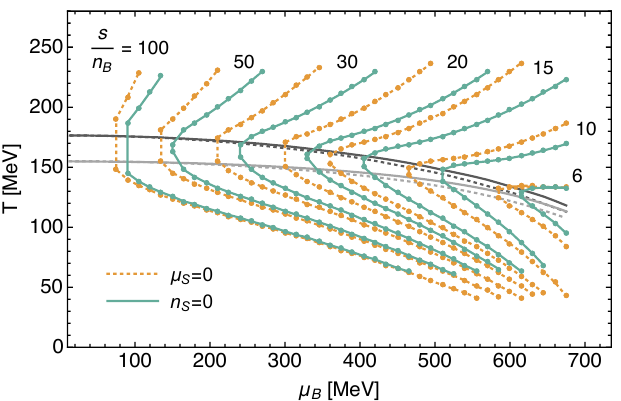
Figure 8: Isentropes in the phase diagram. The dark and light gray lines are the chiral and deconfinement phase boundaries